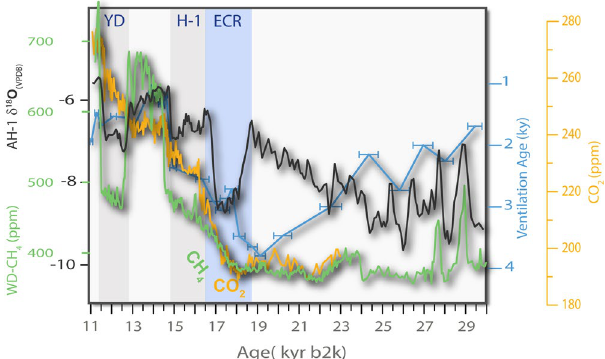
Figure 5. Variations in the Δ 14 C -derived ventilation ages 6 (blue line) compared to FS-AH1 δ 18 O and changes in the concentration of atmospheric CO 227 (yellow line). The timing of the steep decrease in ventilation ages, presumed to result from upwelling in the Southern Ocean sector of the AMOC coincides with the timing of the ECR and the rise in atmospheric CO 2 . Upwelling of cold Southern Ocean water and flooding of the subtropics and the tropics may have led to differential cooling of the subtropics and the tropics, while the secular trends in the polar regions reflect the combined effects of their summer